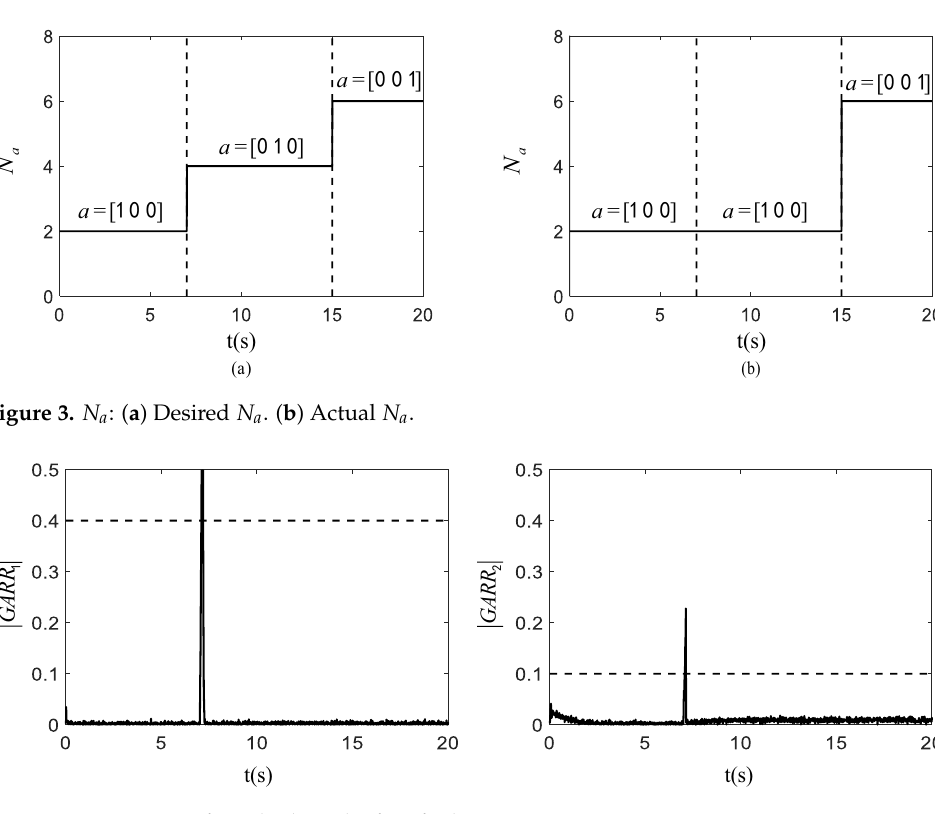
Figure 4. Responses of residuals in the first fault